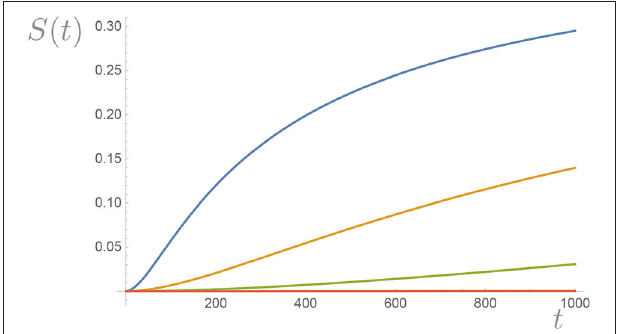
FIGURE 6 | Here we plot S ( t ) as a function of time for a Gaussian wave packet centered at b 2.5 10 − 2 , b 5 10 − 2 , b 7 10 − 2 , and b 10 − 1 with width = = = = b , respectively. Numerical integration plus the approximation (73) was σ = 1 used with the assumption that 2( 1 ) /γ 2 1, all in Planck units. As b = + − − grows the scalar curvature (the cosmological constant) grows and the rate at which entropy increases grows as well. For b 1, an effective unitary ≪ evolution is